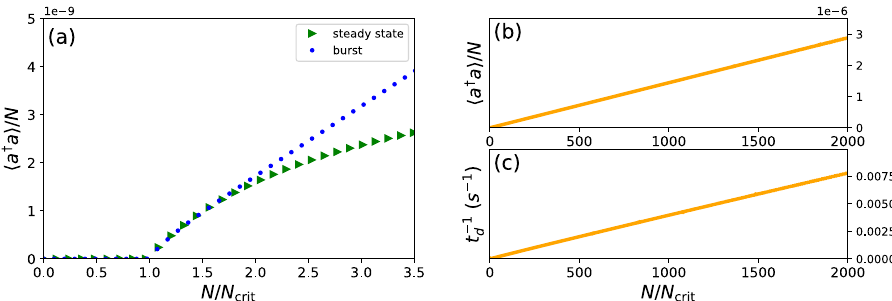
Fig. 3 Photon production phase transition. a Scaled cavity photon number 〈 a † a 〉 / N versus N / N crit at the instant of the fi rst vacuum photon production burst peak (blue dots) and in the long time limit steady state (green triangles). b First peak value of 〈 a † a 〉 / N versus N / N crit for N ≫ N crit . c First peak inverse delay time 1/ t d versus N / N crit for N ≫ N crit . Assumed parameters are γ c ≈ 2 × 10 4 s − 1 , γ d ≈ 2 × 10 − 4 s − 1 , and N crit ≈ 4 × 10 17